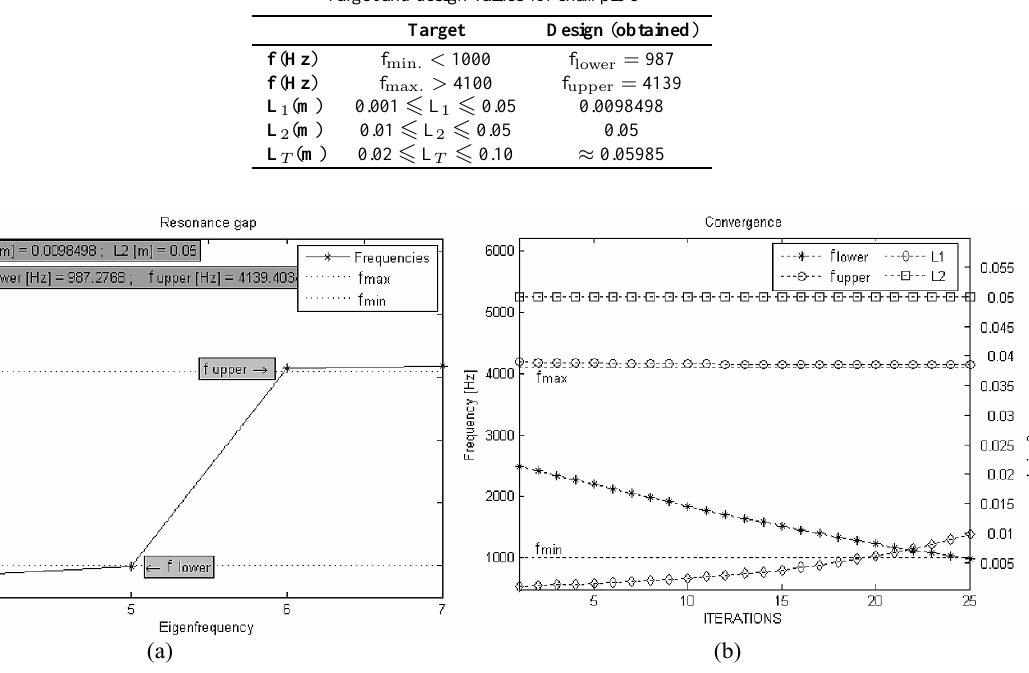
Fig. 11. Example 3: a) Resonance gap obtained; b) Frequencies and material length